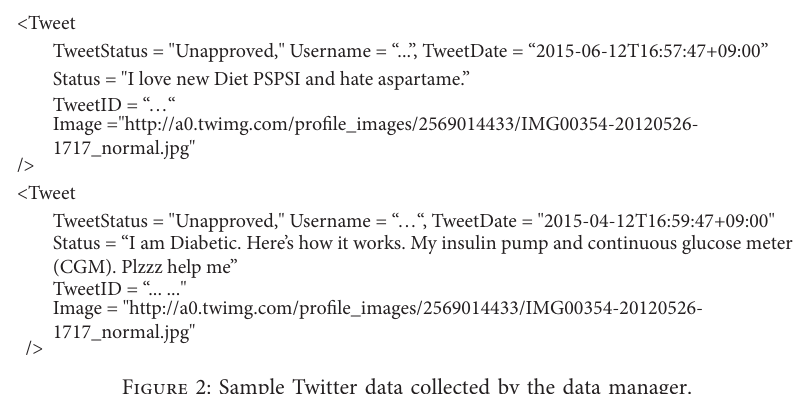
Figure 2: Sample Twitter data collected by the data manager. Table 1: A sample of knowledge extracted by profile builder, with confidence scores shown in parenthesis. Tweet